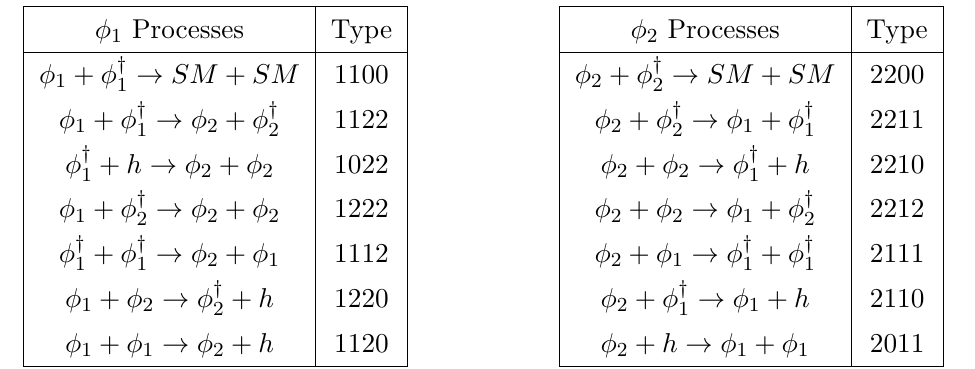
Table 1 . The 2 ! 2 processes that are allowed in the Z 5 model and that can modify the relic density of (cid:30) 1 (left) and (cid:30) 2 (right). h denotes the SM Higgs boson. Conjugate and inverse processes are not shown.